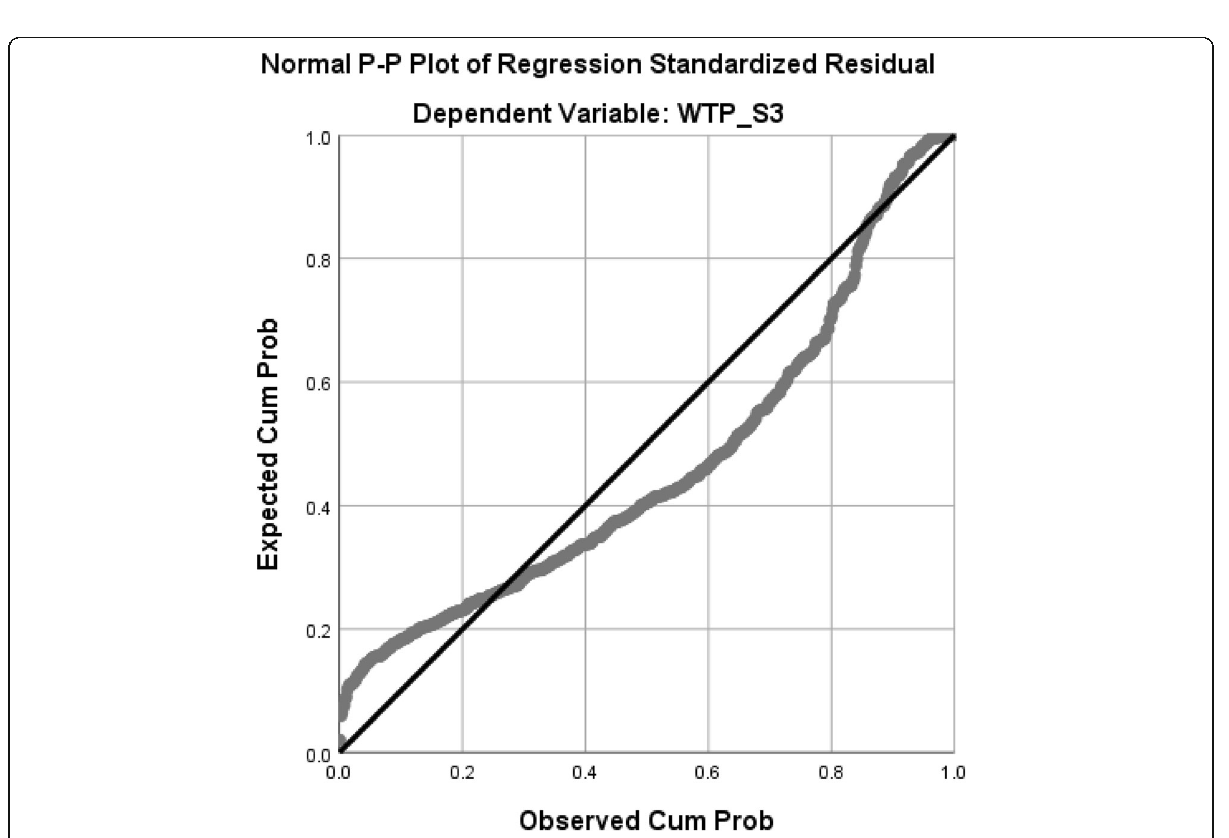
Fig. 12 Normal P-P Plot of the residuals of regression of Model C (explanatory variables against WTP for